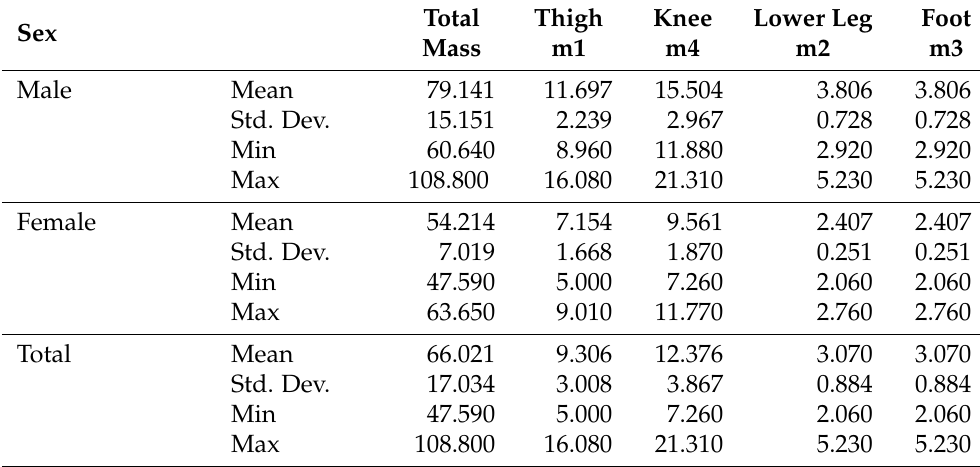
Table 9. Report Mass and Centre Mass